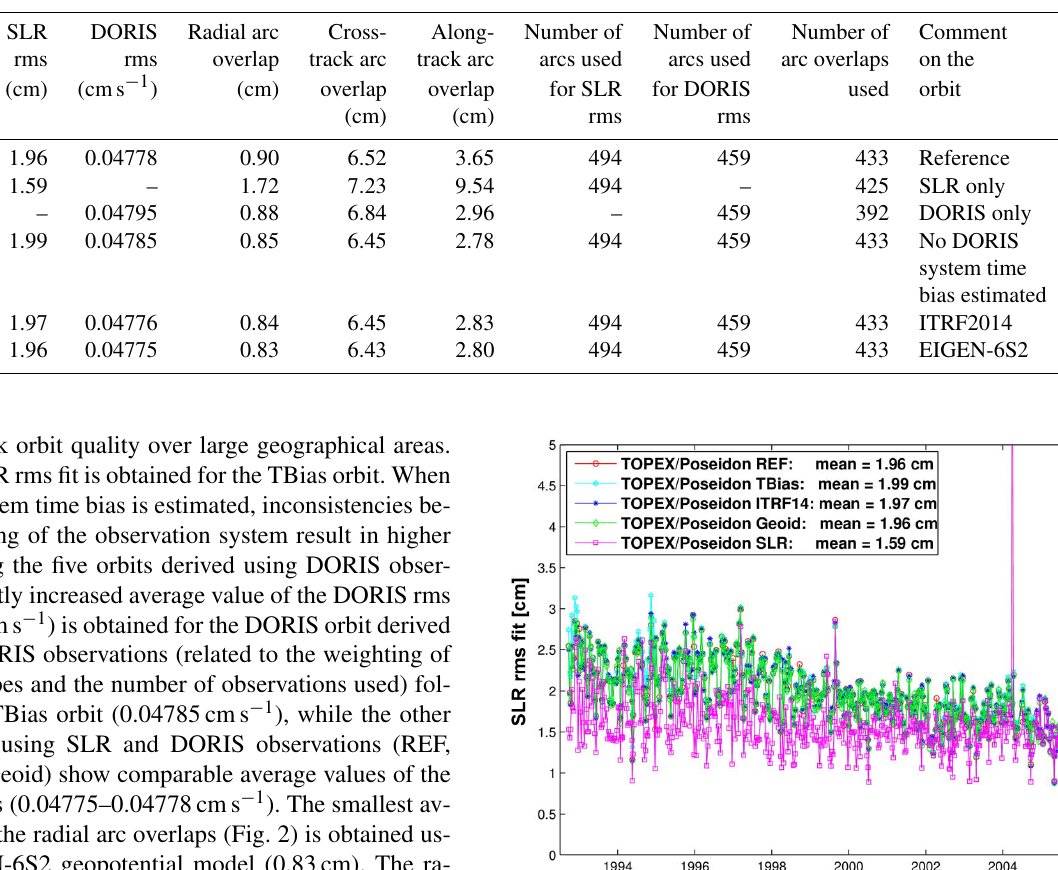
Table 2. Average values of SLR and DORIS root mean square (rms) fits; radial, cross-track, and along-track 2-day arc overlaps; and the number of the arcs used to compute these values for the reference and five test orbits.